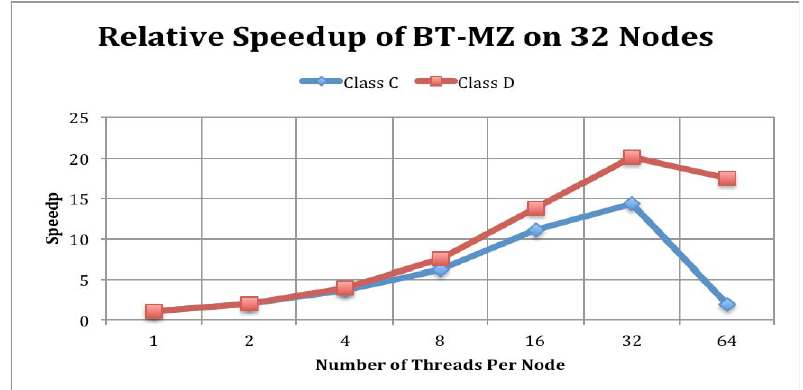
Figure 6. Performance comparison of BT-MZ on 32 Nodes with different number of threads per node